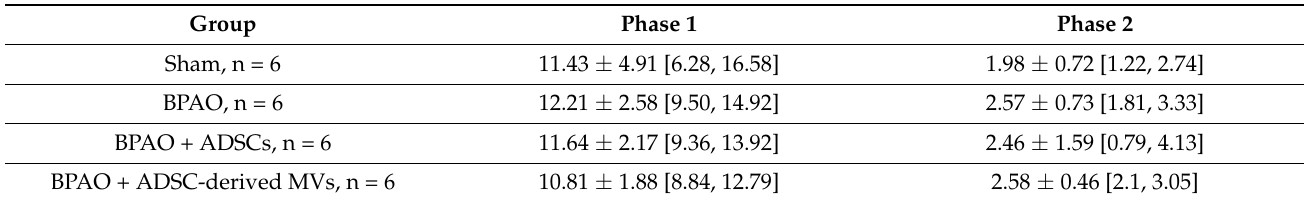
Table 3. The duration of phasic 1 and phasic 2 micturition contraction on transcystometrogram. Data are presented as mean ± standard deviation; the 95% confidence intervals are shown in brackets. * p < 0.05 vs. sham group by two-tailed non-paired Student’s t -test. # p < 0.05 vs. BPAO group by two-tailed non-paired Student’s t -test.